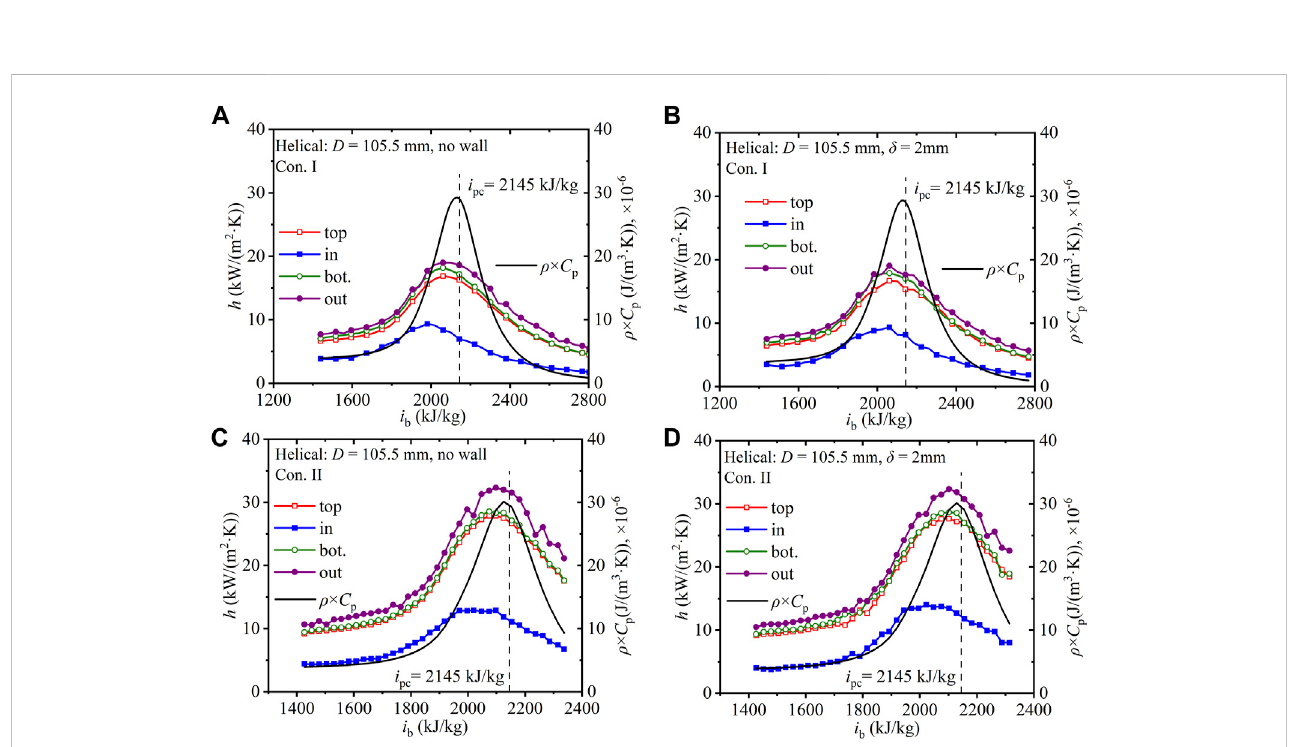
temperature appears when θ increases from 0 ° to 360 ° , with the preceding wall temperature changing drastically before reaching T w,max . The non-uniformities in the wall temperature shown in Figure 9 result from the combined effects of buoyancy and centrifugal forces. θ of T w,max aids the comparison of the relative scale between the centrifugal force and buoyancy. In Figure 9A, for the temperature regions from T w, max < T pc to T b < T pc < T w,min , the maximum wall temperature moves from the inside to the top (from 64 ° to 54 ° ), which proves that the buoyancy effect is enhanced. For the temperature region of T w,max = T pc , the maximum wall temperature moves from the top to the inside (from 54 ° to 72 ° ), which proves that with increase in the fl uid temperature, the density decreases whereas